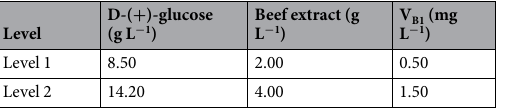
Table 15. L 8 (2 7 ) orthogonal design for optimisation of the culture